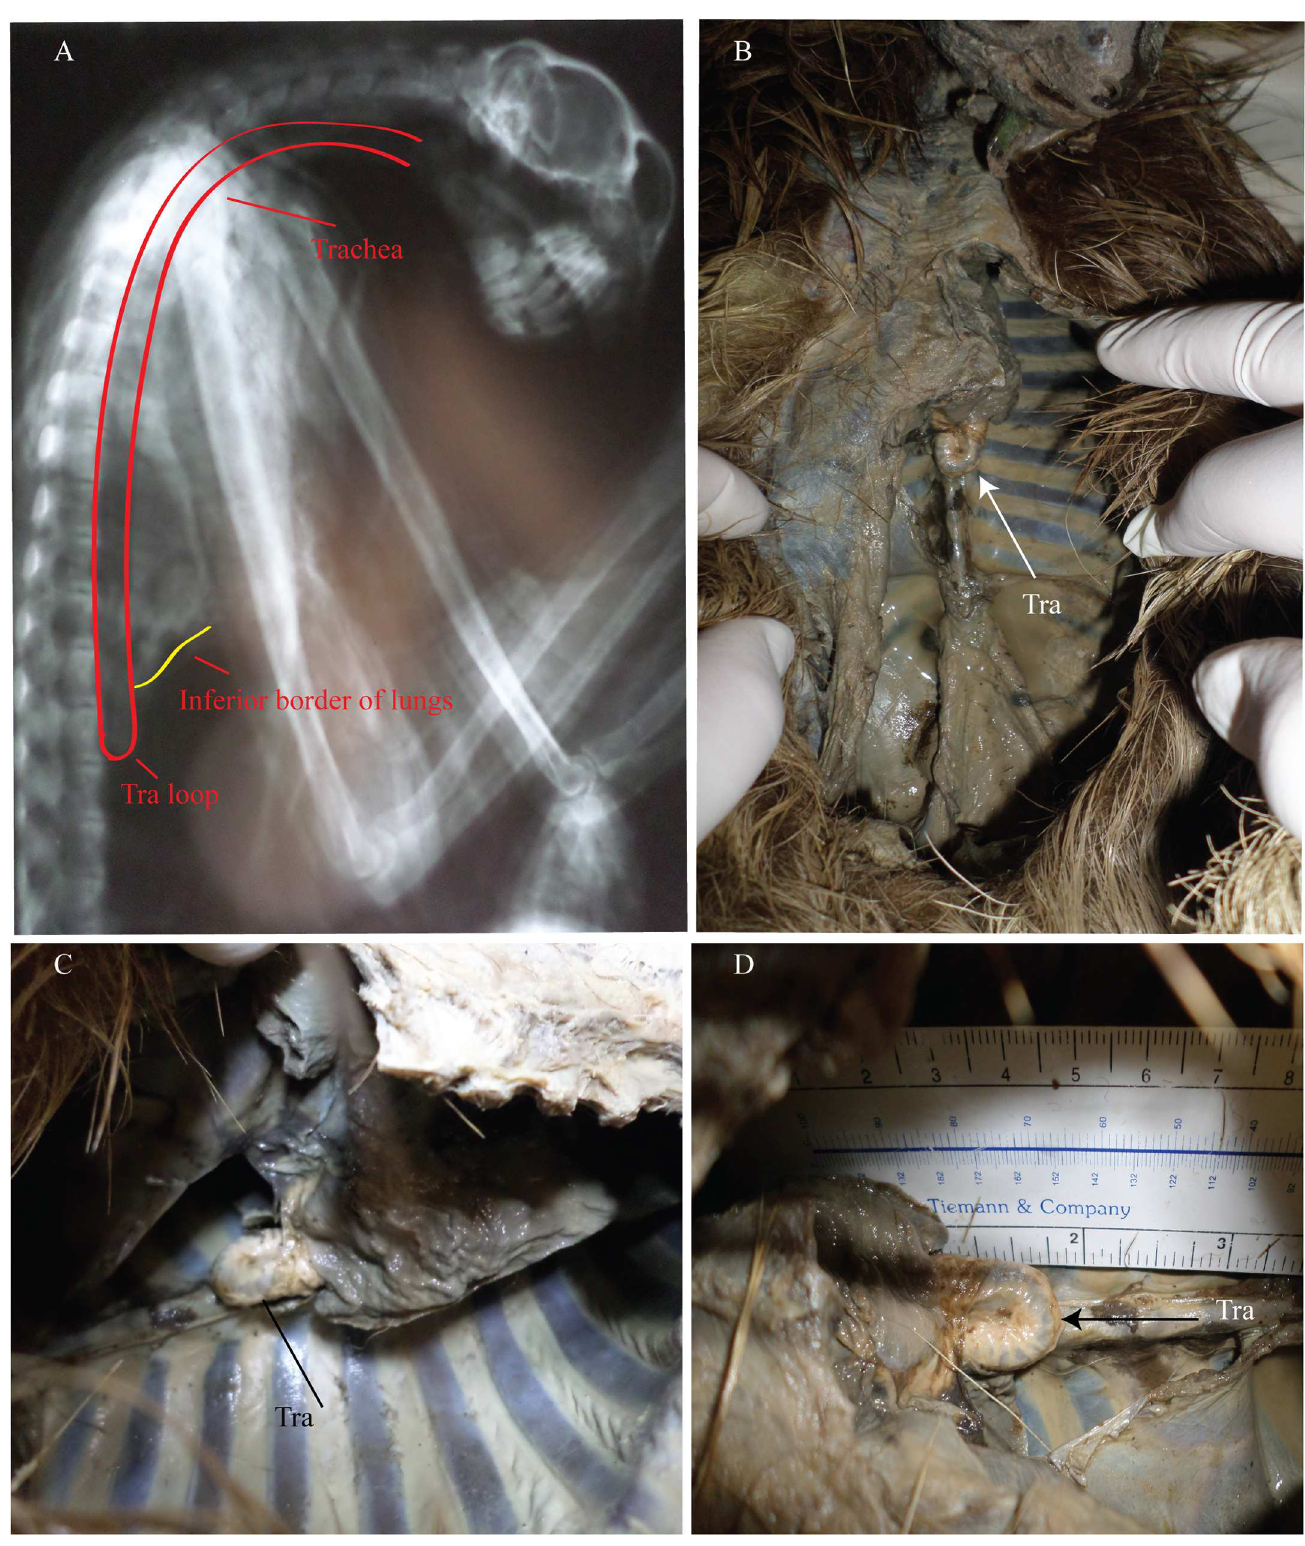
Fig 11. Bradypustridactylus views of the trachealloop. (A) lateralradiograph of the course of the trachea.(B-D)views of the trachealloop. Tra = trachea;Tra loop = trachealloop.